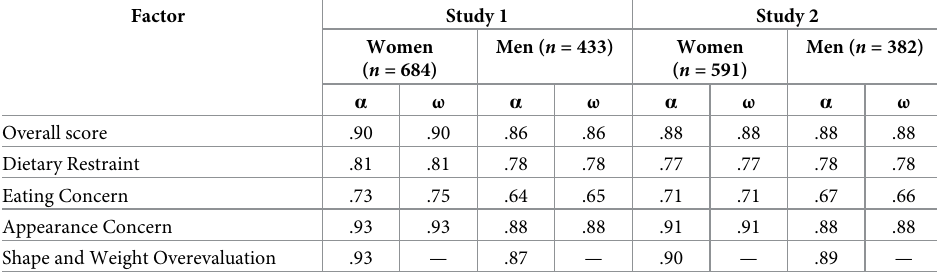
Table 6. Internal consistency of factor scores of the 14-item eating disorder examination questionnaire 6.0 in women and men.